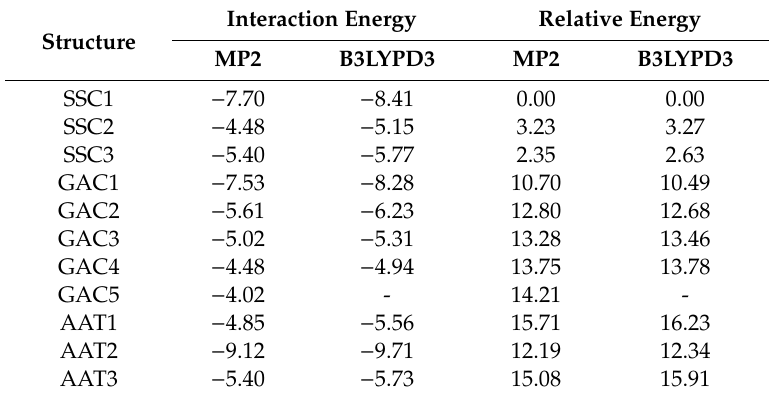
Table 2. Computed interaction energies and relative energies compared to global minimum SSC1 (in kJ mol − 1 ). Interaction Energy Relative Structure